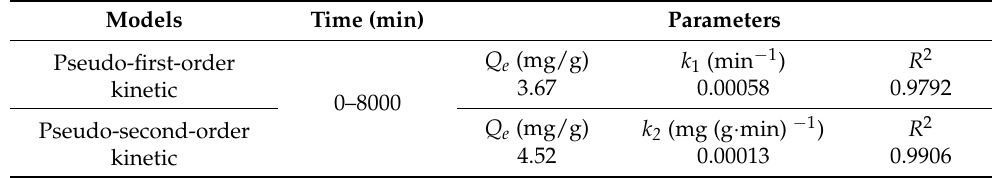
Figure 13. The best-fitted curves of As(III) adsorption by MGOCS using pseudo-first-order and pseudo-second-order kinetic models, respectively. Table 1. Fitting parameters of pseudo-first-order and second-order kinetics for 5 mg/L As(III) adsorption on